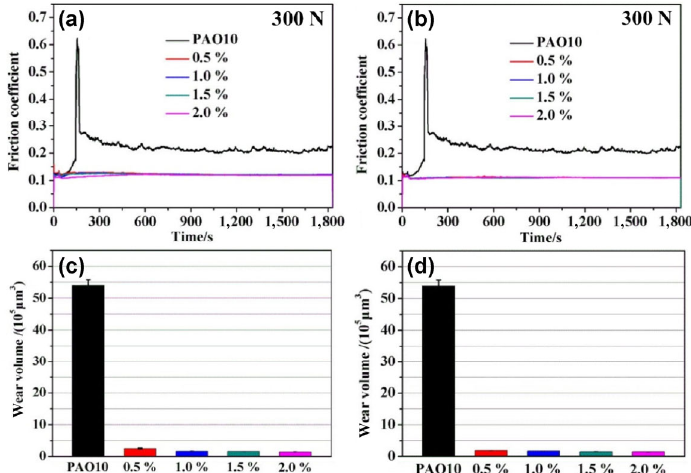
Fig. 3 Friction-reducing and anti-wear properties of (a, c) N 88816 S P and (b, d) P 888S S P at different mass concentration for steel/steel contacts at 300 N, 25 Hz, and